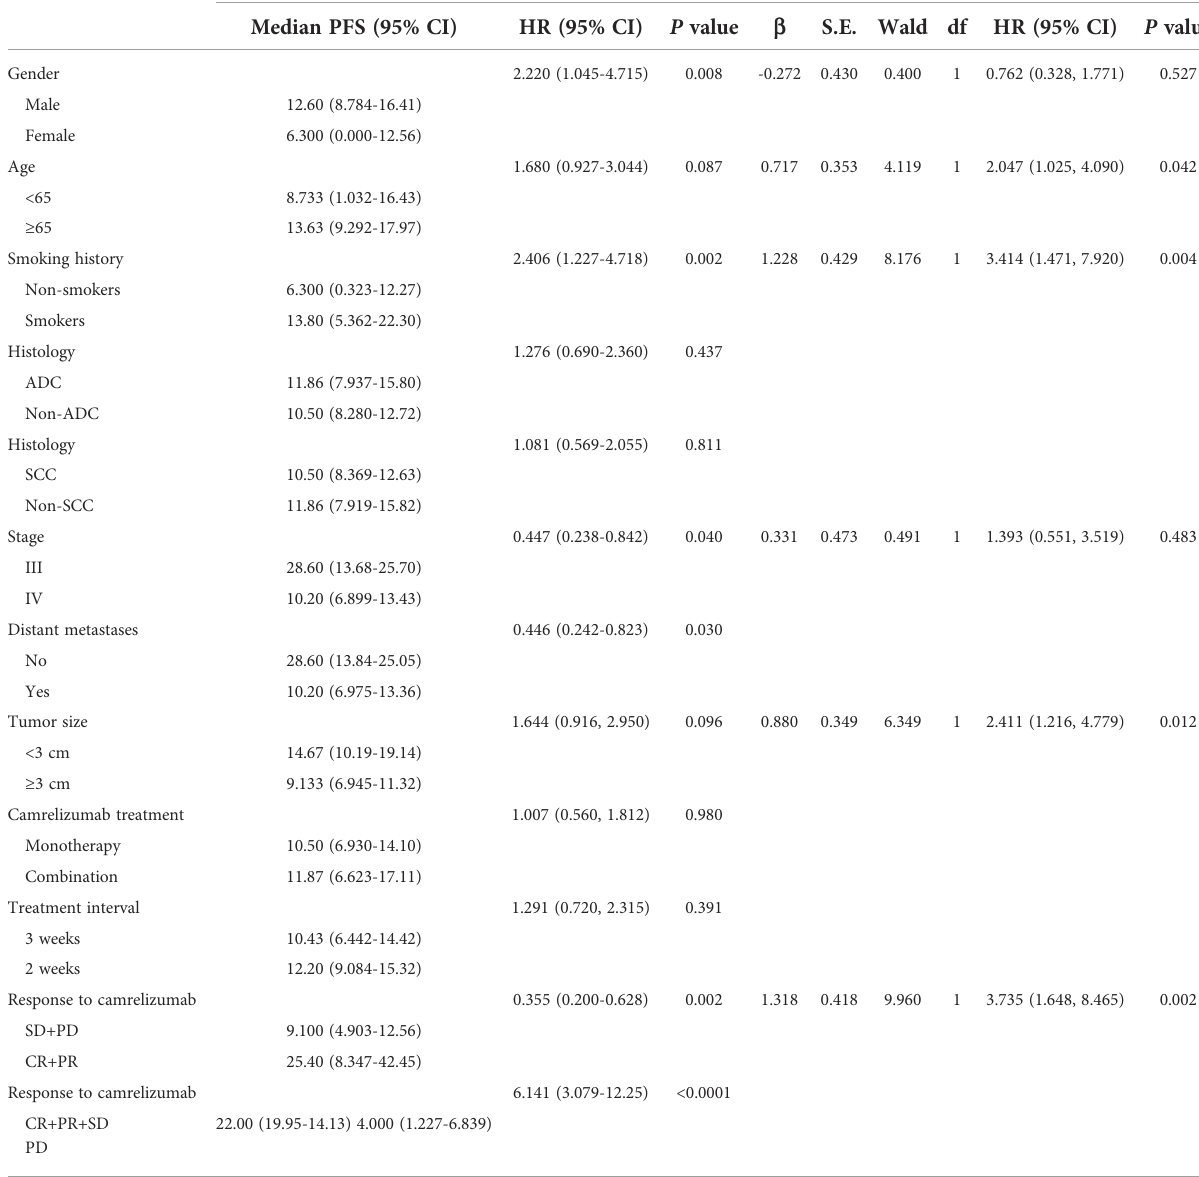
TABLE 4 The univariate and multivariate analyses of progression free